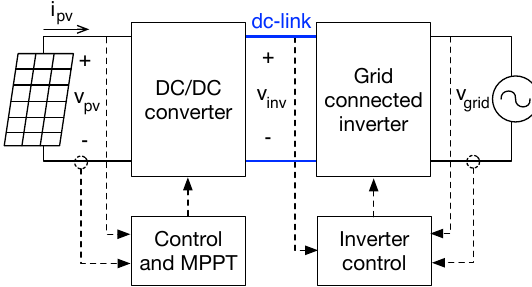
Figure 1. Grid-connected PV